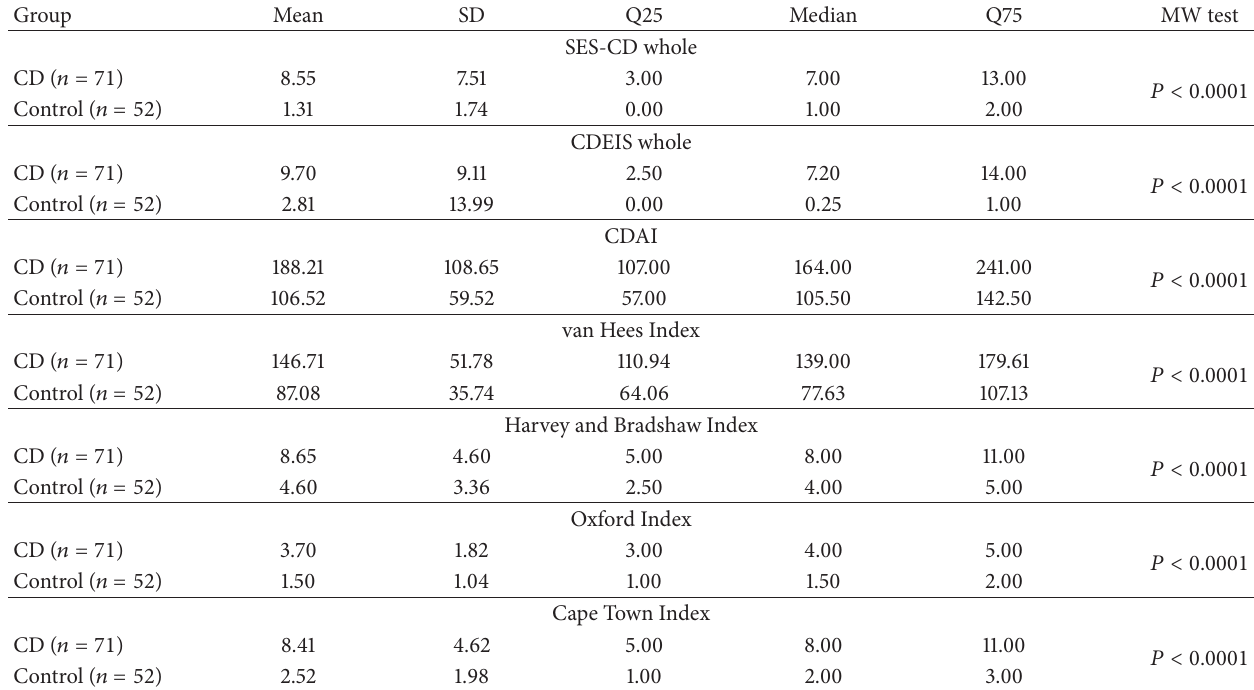
Table 7: Assessment results in each of the indices in CD patients as well as in the control group presented in the form of descriptive statistical parameters: mean values, standard deviation, median, quartiles (Q25 and Q75), and Mann-Whitney (MW)